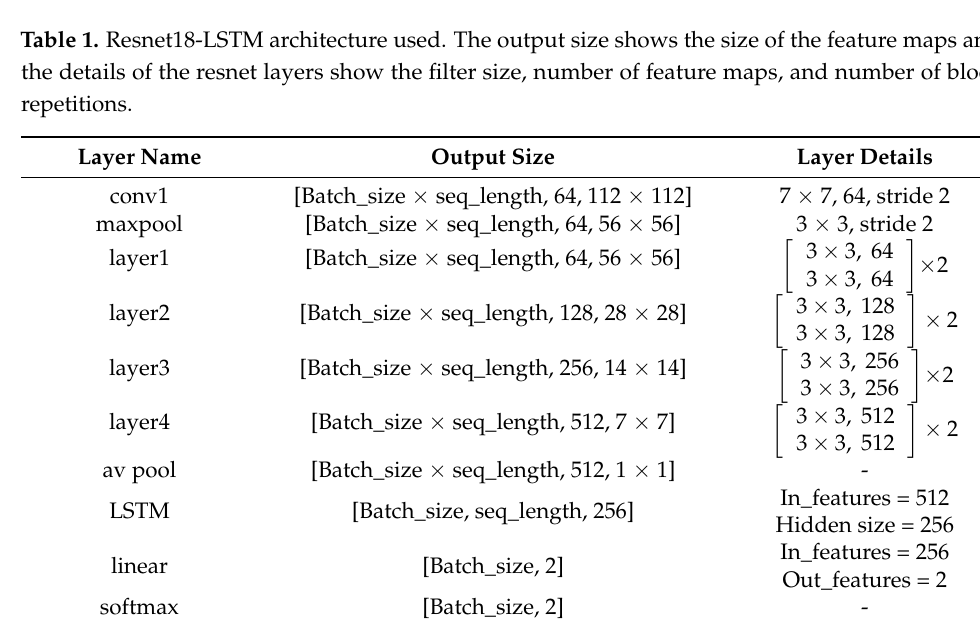
Table 1. Resnet18-LSTM architecture used. The output size shows the size of the feature maps and